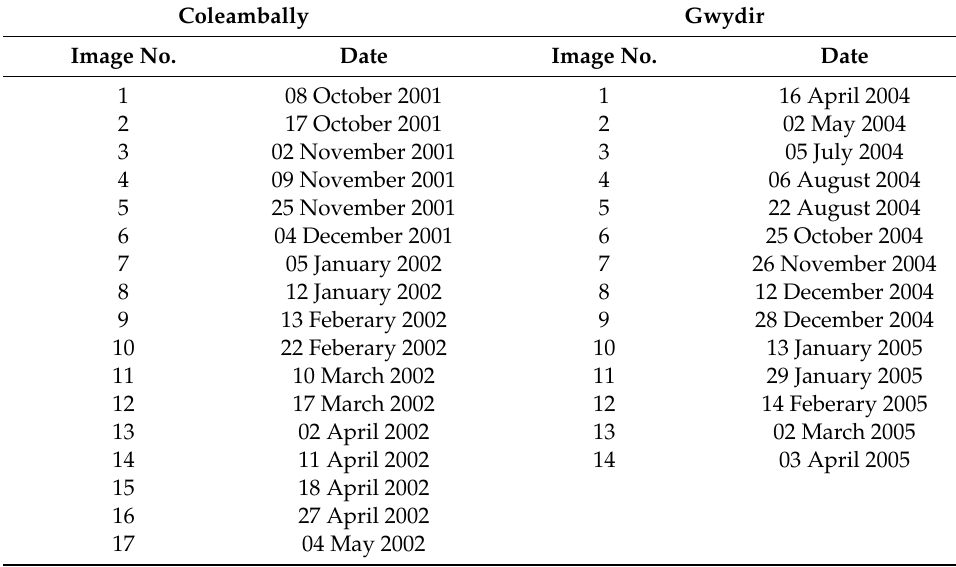
Table 1. Landsat and MODIS image pairs for Coleambally and Gwydir sites. Coleambally Gwydir Image No. Date Image